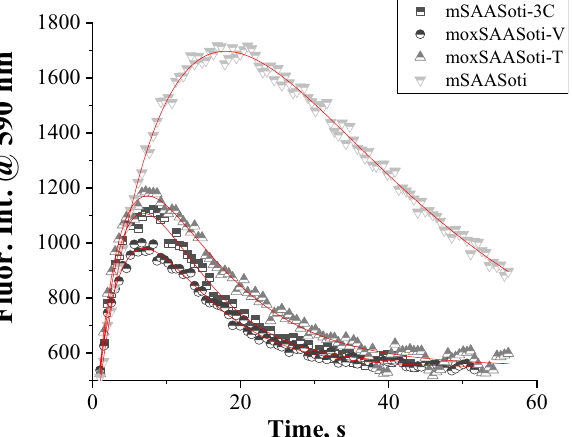
Figure 4. Green-to-red photoconversion of mSAASoti variants induced by 400 nm combined with 550 nm illumination. Experimental data are represented by dots, fitting by red lines. Protein samples prepared in 200 mM Tris–HCl, pH